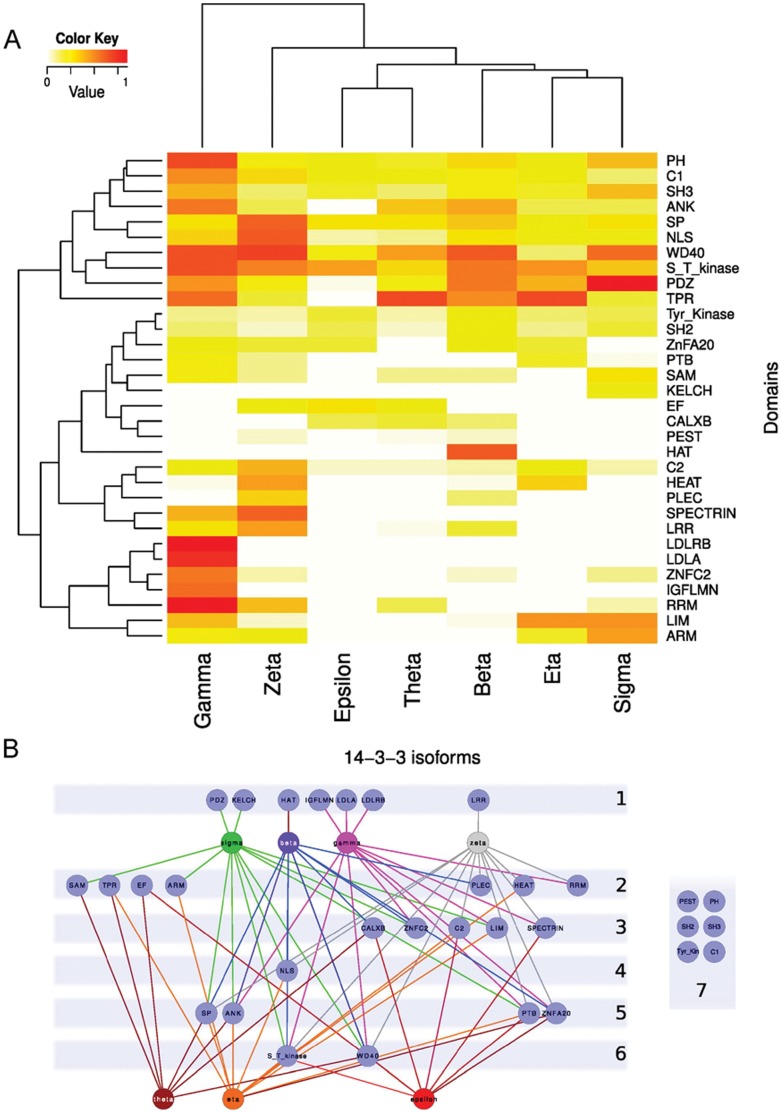
Domain composition of 14-3-3 isoforms’ partners.A) Heat map of the relative frequencies of protein domains within the seven 14-3-3 paralogs networks. The top 10 most abundant domains of each network were compared for all the networks. The color key represents the relative frequency, from white (lower value) to red (higher value). Fisher exact test comparison was performed (see text for details). B) Network representation of domains (light-blue nodes) interactions with 14-3-3 isoforms. Statistically significant over representation or absence of interaction is indicated by colored lines connecting each isoform with a domain node, except for the group of six domains that interact with all the isoforms, which were drawn apart for clarity. The numbers on the right correspond to the number of 14-3-3 isoforms interacting with each domain.